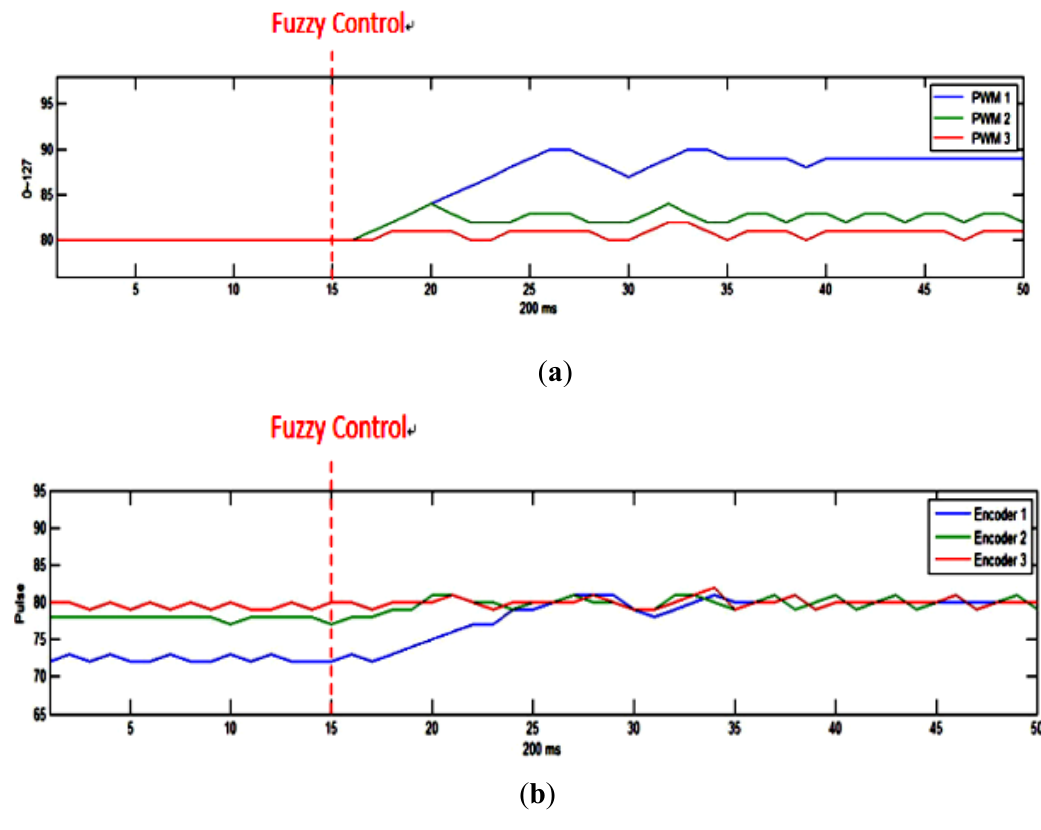
Figure 10. Experimental results of the motor revolution using fuzzy theory. ( a ) PWM tuning curves and ( b ) encoder feedback curves for the three motor